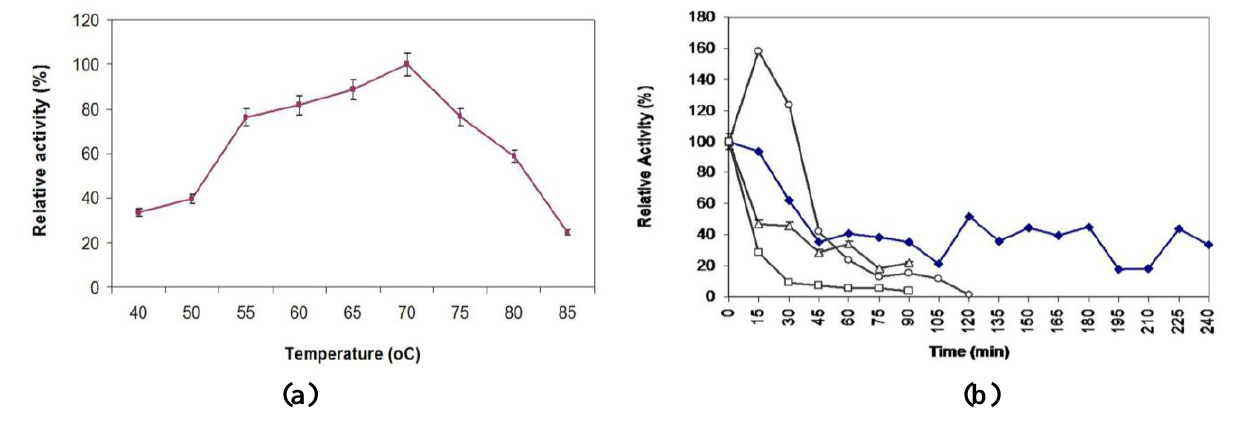
Figure 5. (a) Temperature profile of purified recombinant L2 lipase; and (b) Thermostability profile of purified recombinant L2 lipase. The L2 lipase was incubated at different temperatures in Glycine-NaOH buffer pH 9 and the residual activity was assayed at 70 °C (optimum temperature). The symbols used are: (□) 80 °C; ( ∆ ) 70 °C; (○) 65 °C; and (♦) 60